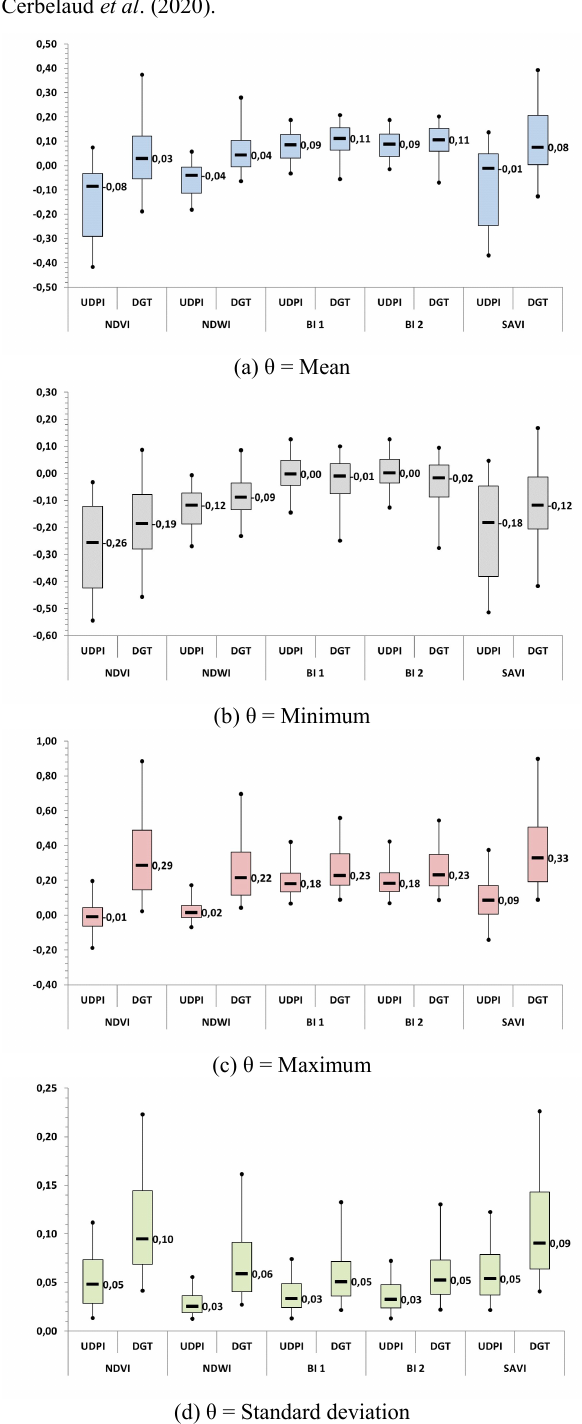
Figure 6 . Boxplot of (𝑅𝐷 (cid:3038) ) (cid:3087) by spectral index k and class